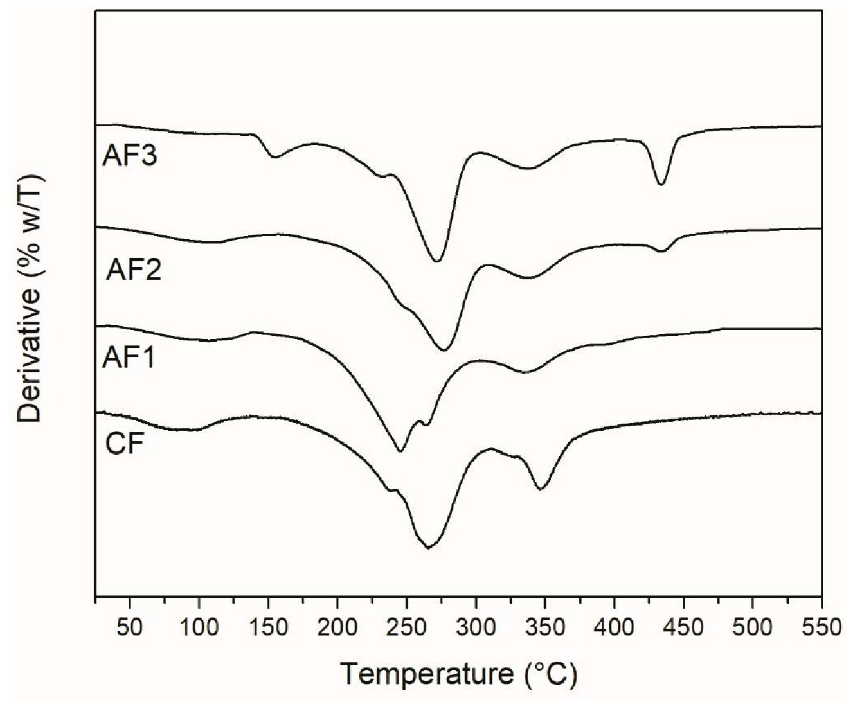
Fig 2. DTG thermograms of gelatin films studied. AF: Active Film, CF: Control Film.